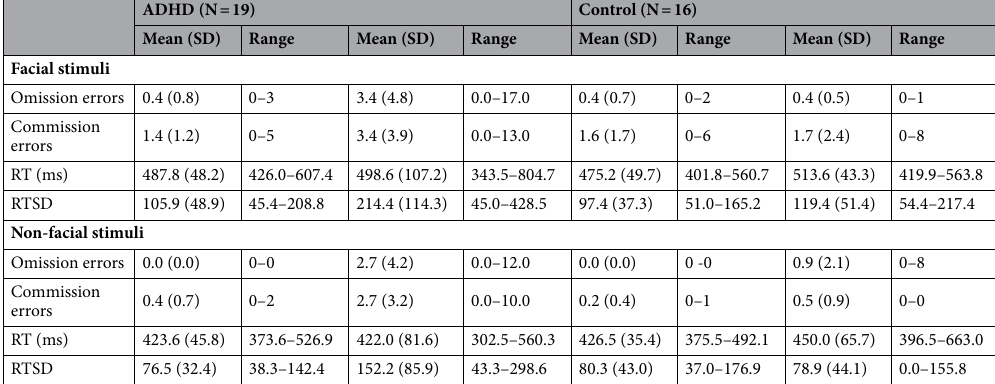
Table 2. Measures of the oddball task: descriptive statistics. Performance of the ADHD and control group participants in response to target faces/shapes (omission errors, reaction time [RT], and reaction time variability [RT standard deviation, RTSD]) and non-target faces/shapes (commission errors) before (time 0, baseline) and after (0 + 25) sleep deprivation.